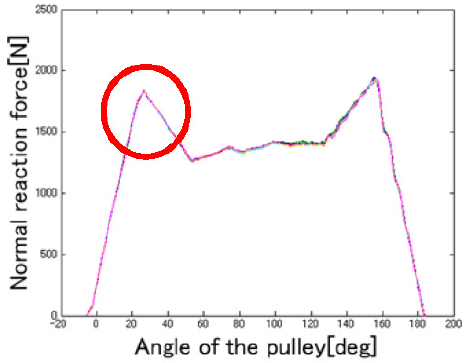
Figure 12. Normal contact force at each node of the element.